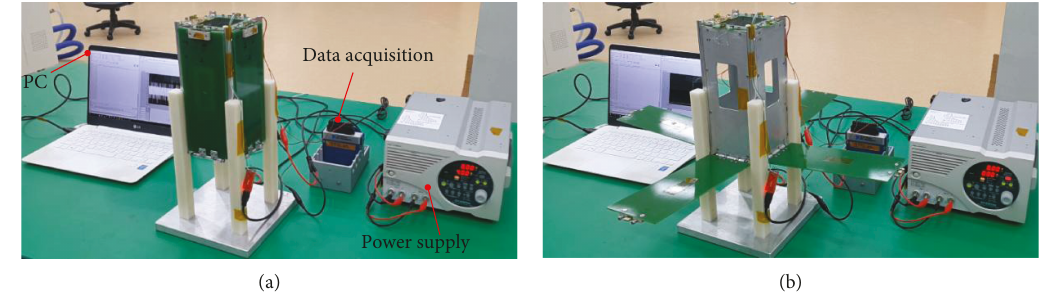
Figure 5: Release function test setup: (a) before and (b) after deployment of solar